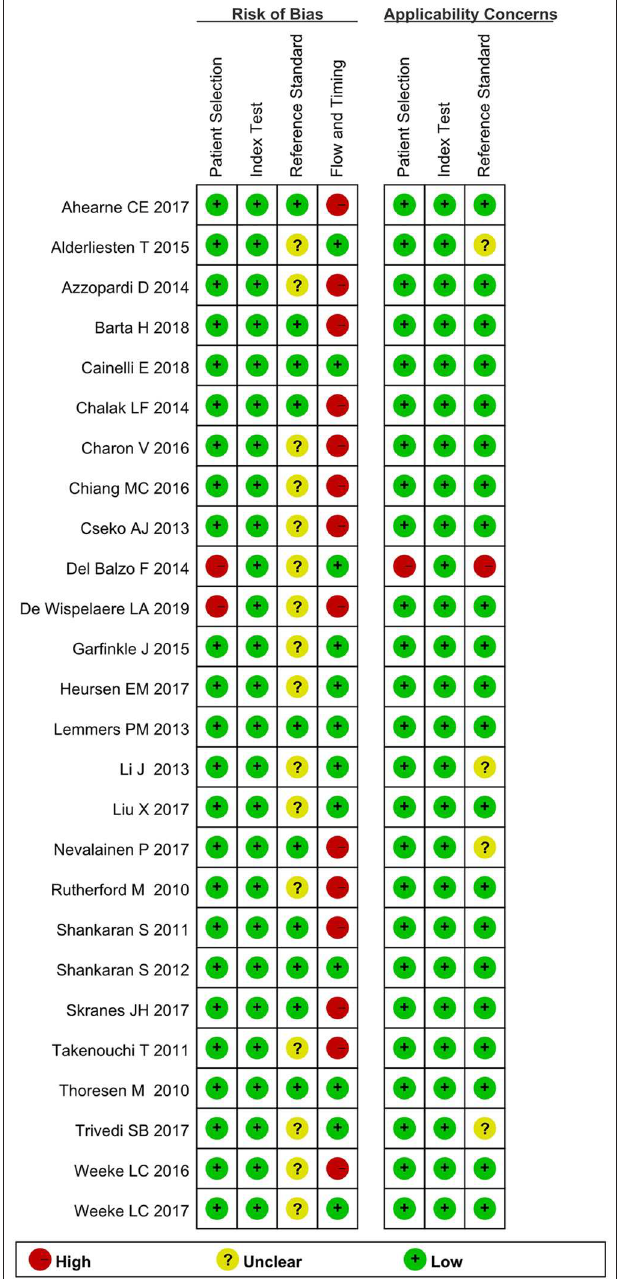
FIGURE 2 | Quality assessment of included studies using